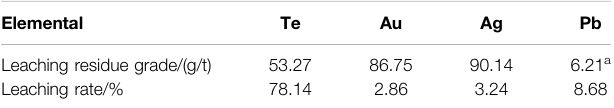
TABLE 2 | Results of an optimum experiment.